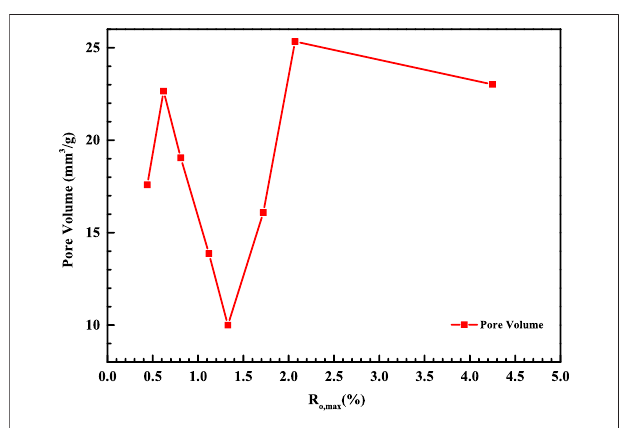
Figure 2 . The corrected SAXS data was used for subsequent processing and analysis.